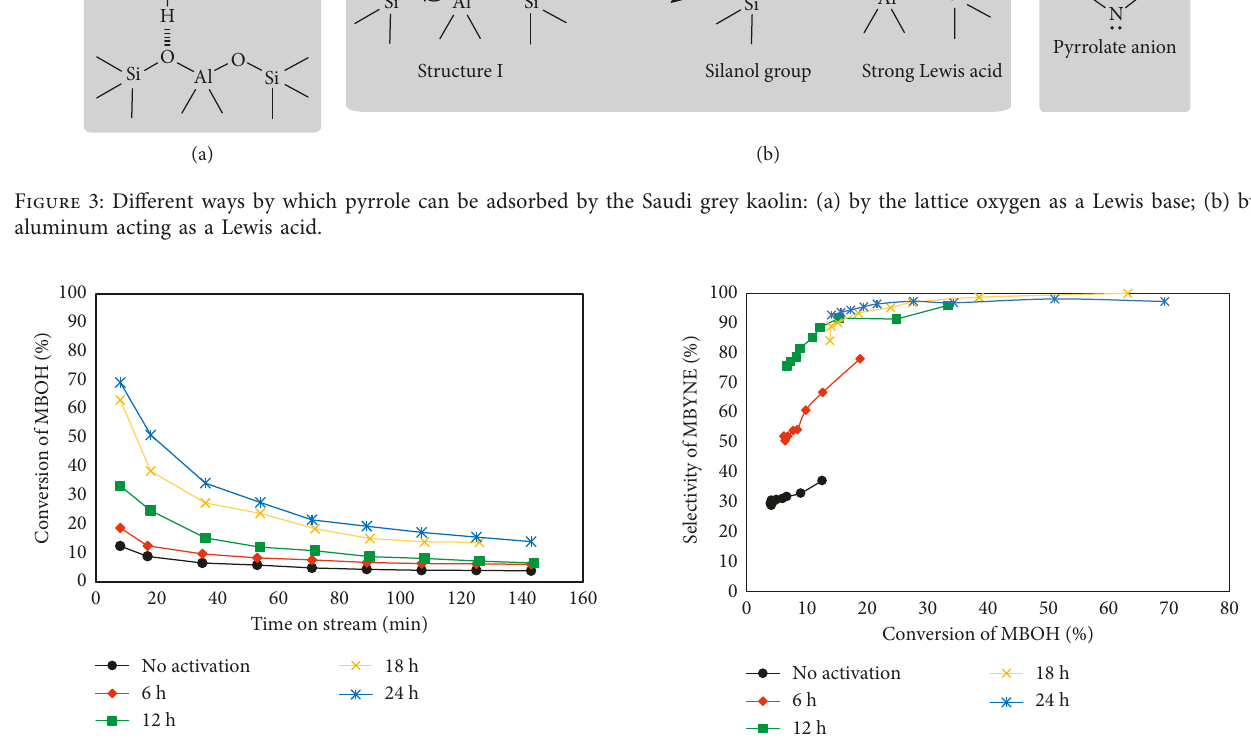
Figure 5: Product selectivity of the MBOH conversion at a reaction temperature of 130 ° C (clay preheated before starting the MBOH catalytic reaction at 400 ° C under nitrogen stream with different holding times: 6, 12, 18, and